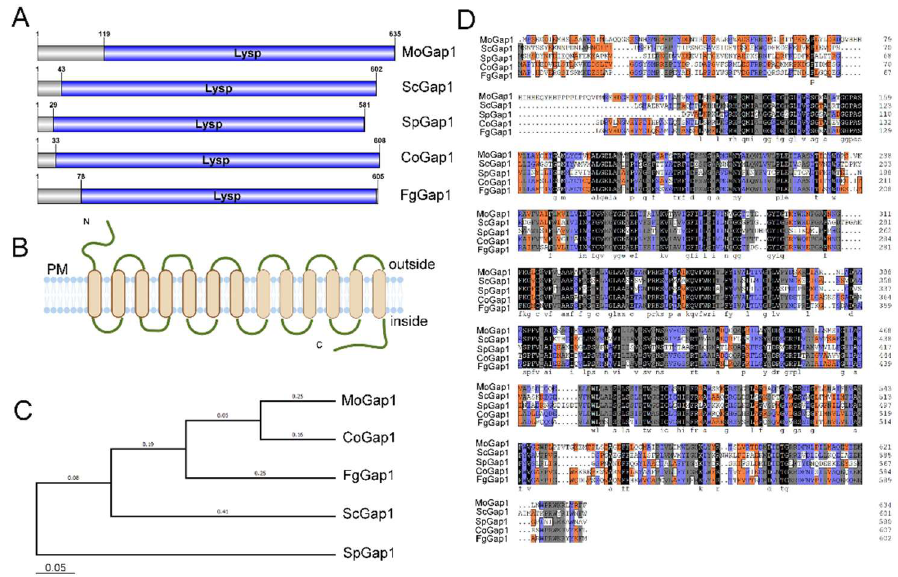
Figure 1. Identification of MoGap1 in M. oryzae . ( A ) Gap1 proteins of M. oryzae , S. cerevisiae , S. pombe , C. truncatum , and F. graminearum shown using IBS 1.0 software. Lysp: amino acid permease domain. ( B ) Schematic diagram of a Gap1 protein that contained 13 transmembrane regions. ( C ) Phylogenetic trees of the Gap1 proteins constructed using MEGA 7.0. ( D ) Multiple sequence alignment shown using DNAMAN software.